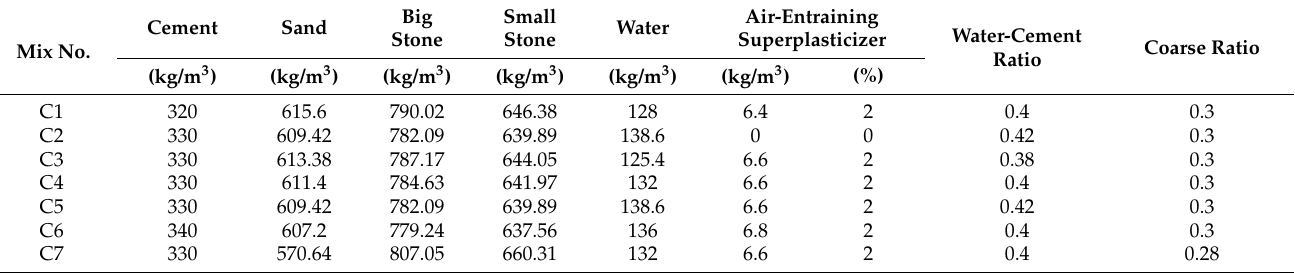
Table 5. Concrete mix